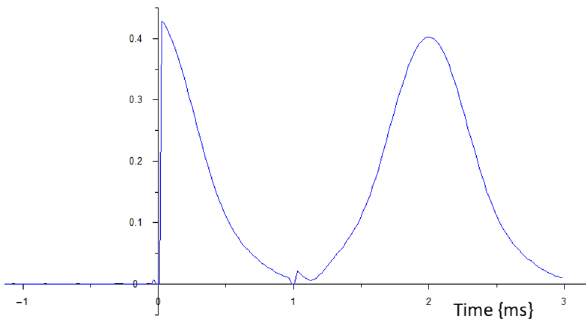
Fig. 2 A single-shot time-domain NMR trace, with free-induction decay (FID) and echo, in a 114 mg hexadecane liquid sample in a standard 5 mm diameter NMR sample